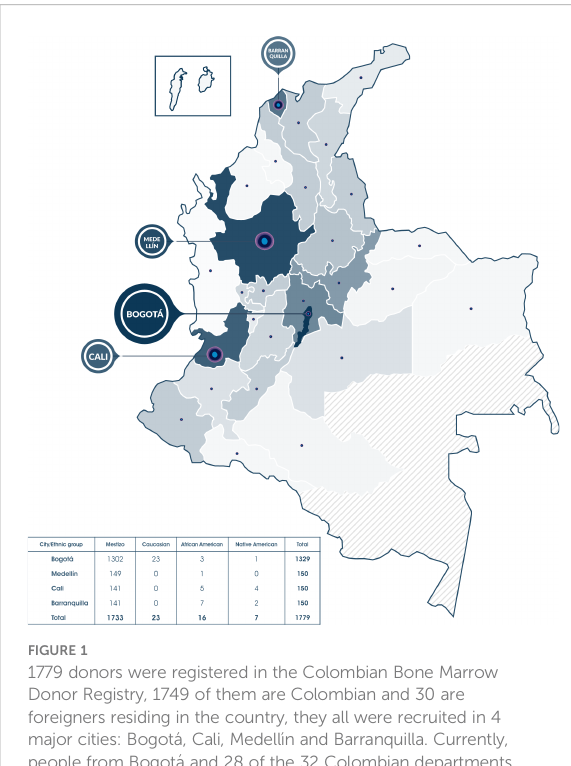
FIGURE 1 1779 donors were registered in the Colombian Bone Marrow Donor Registry, 1749 of them are Colombian and 30 are foreigners residing in the country, they all were recruited in 4 major cities: Bogota ́ , Cali, Medell ı ́ n and Barranquilla. Currently, people from Bogota ́ and 28 of the 32 Colombian departments (except Amazonas, Vaupe ́ s, Guaviare, and Guain ı ́ a) had